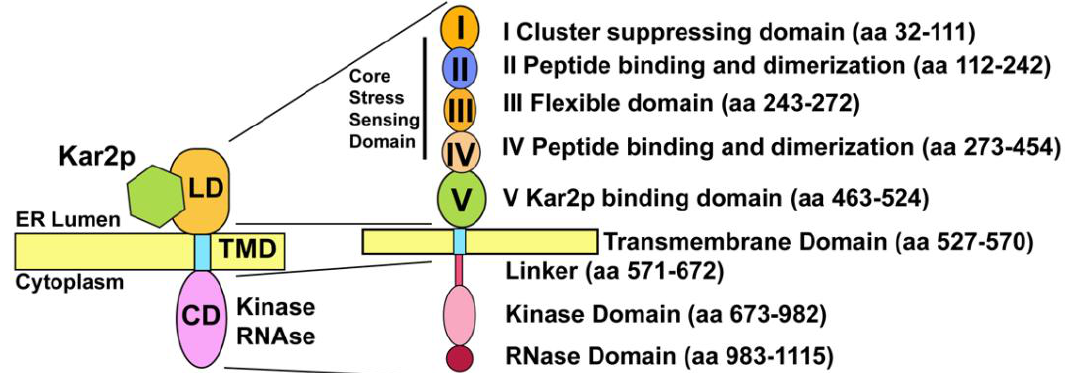
Figure 2. Functional domains of the Ire1p. LD = Luminal Domain, TMD = transmembrane domain, CD = cytoplasmic